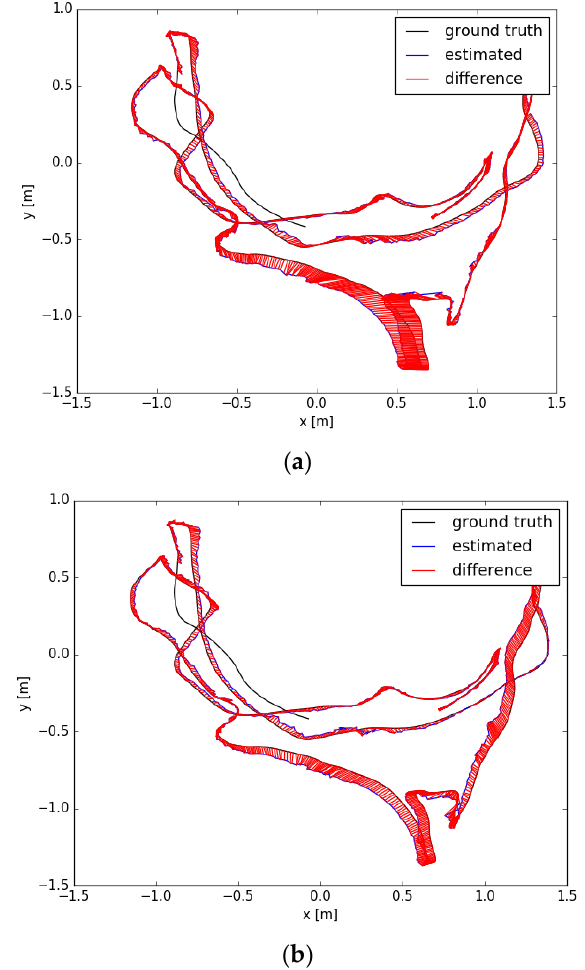
Figure 6. The comparison of the actual mapping trajectory and the real trajectory. ( a ) Trajectory deviation when using B VOC ; ( b ) trajectory deviation when using Fr1 VOC . Table 3. Comparison of trajectory error and size.